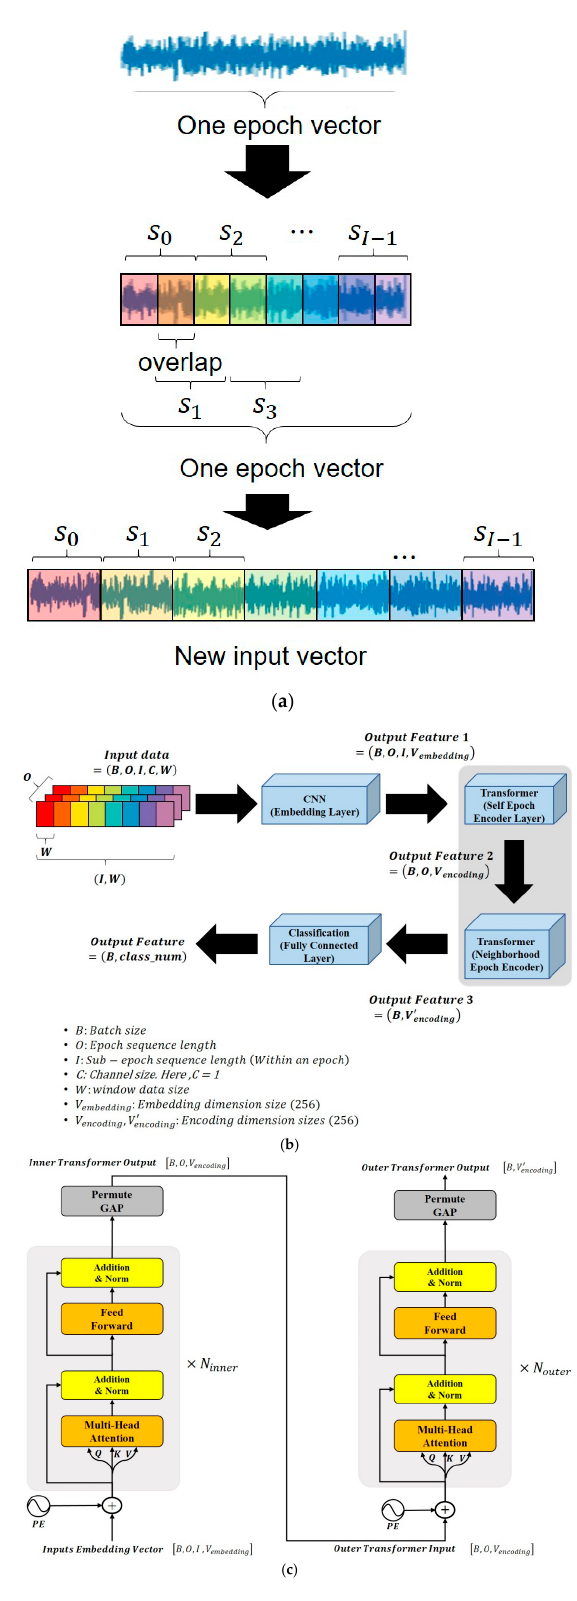
Figure 1. Representative raw data sample from each sleep stage. Bandpass filtering was applied to raw polysomnographic data to reduce impact of noise and for artifact reduction.